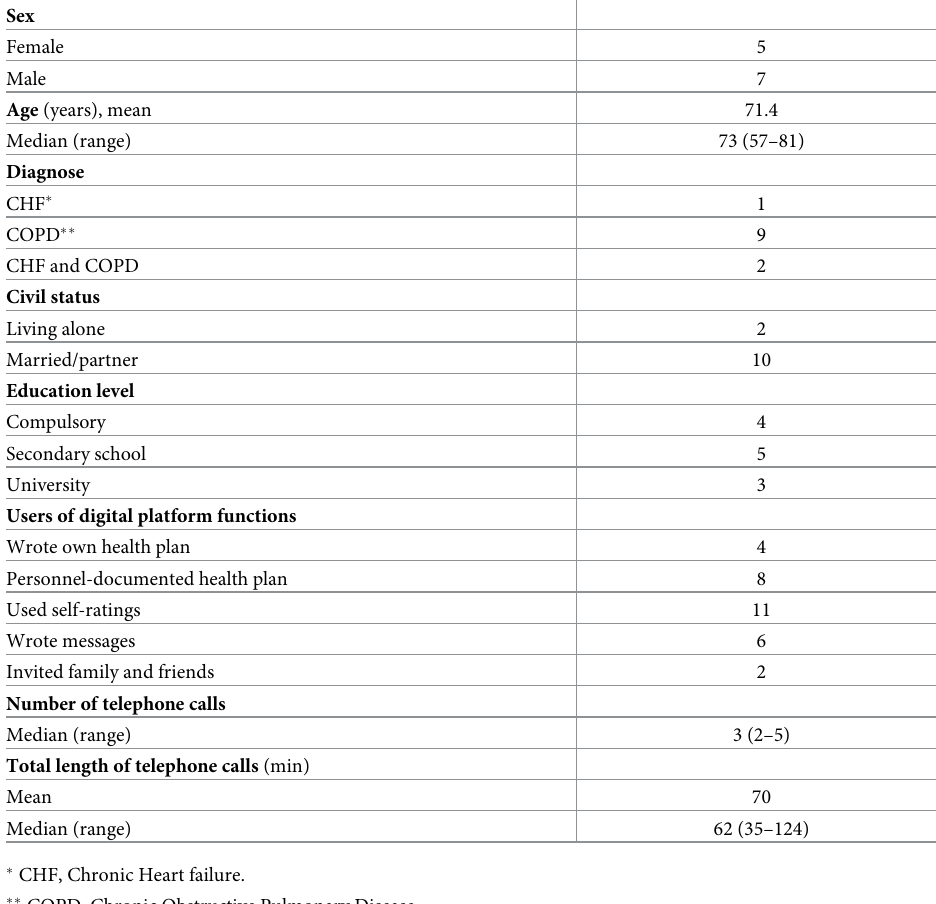
Table 2. Participant characteristics (n =